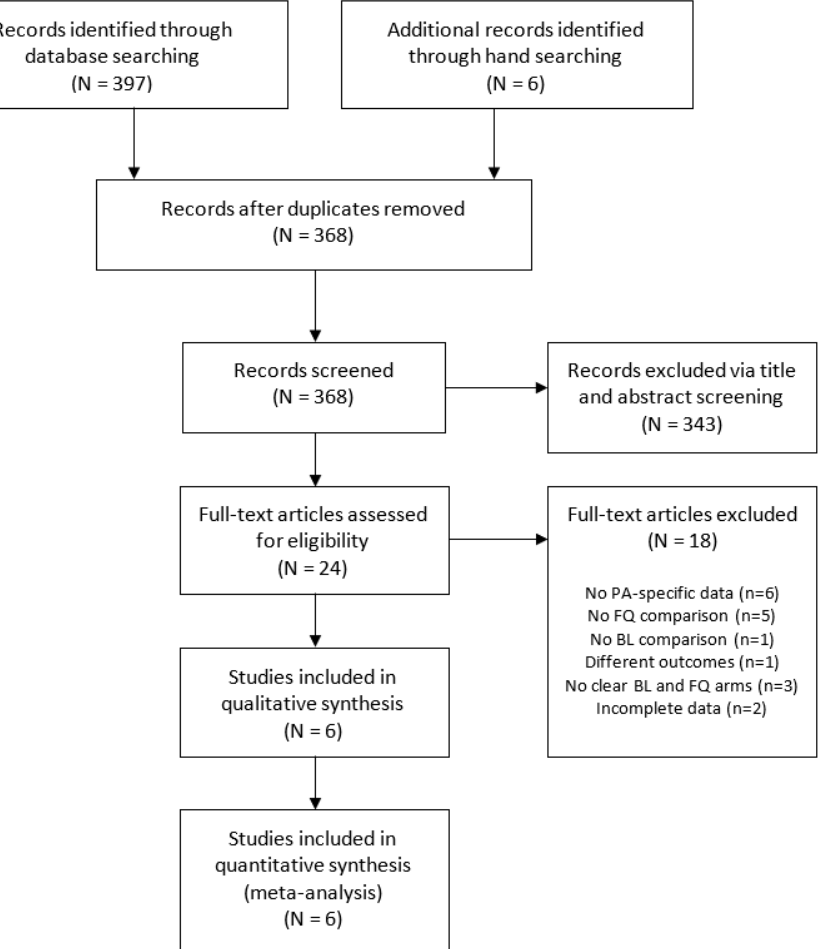
Figure 1. Flow diagram of study selection process.